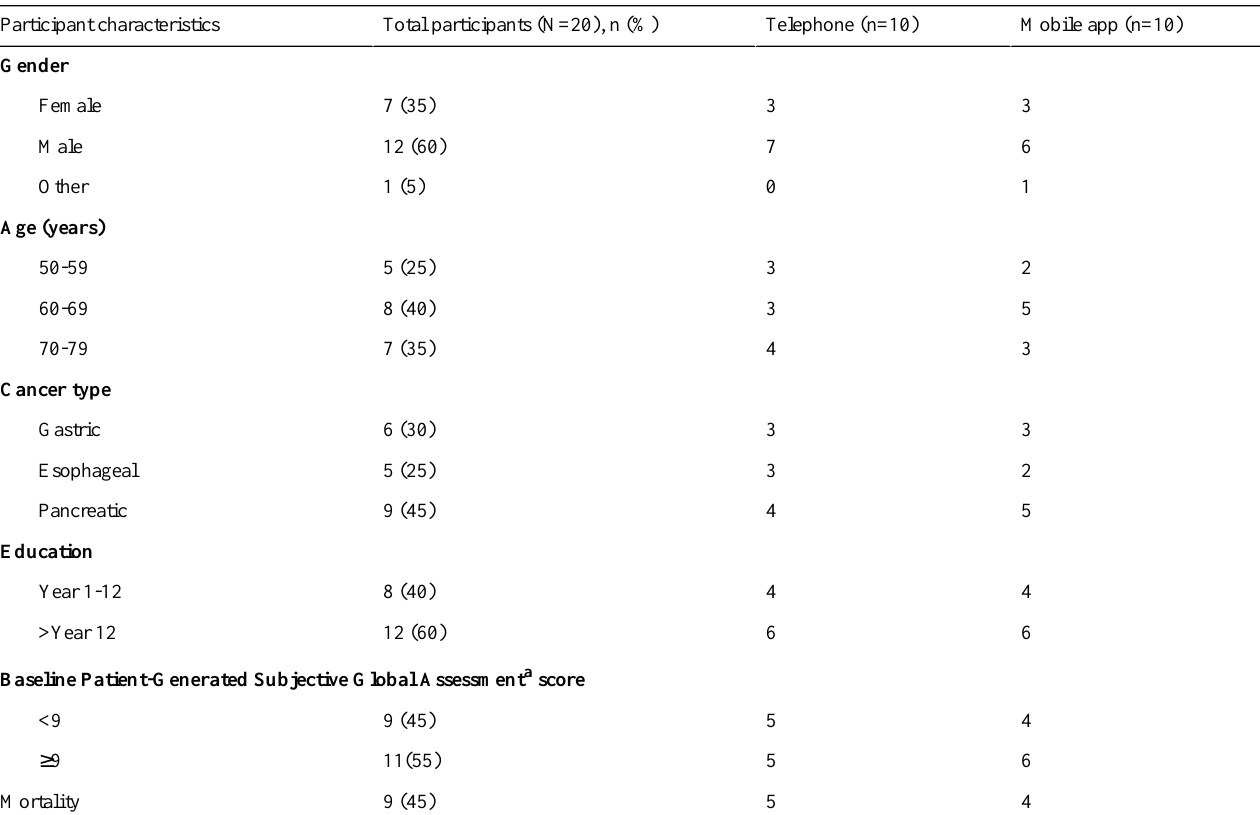
Table 2. Characteristics of the interview